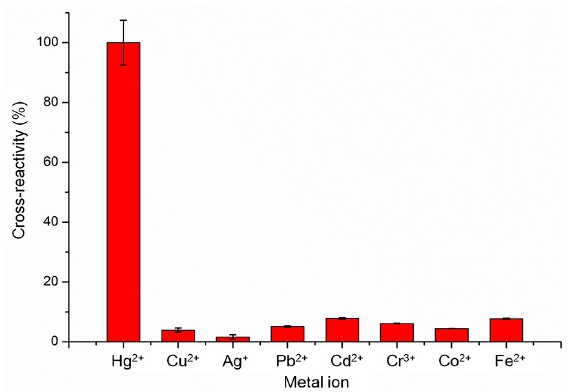
Figure 5. The selectivity of the MR S-phone detection method. The MR S-phone system was used to detect the presence of other metal ions (Cu 2+ , Ag + , Pb 2+ , Cd 2+ , Cr 3+ , Co 2+ , and Fe 2+ ). Each value represents the mean of three independent experiments ( n = 3).